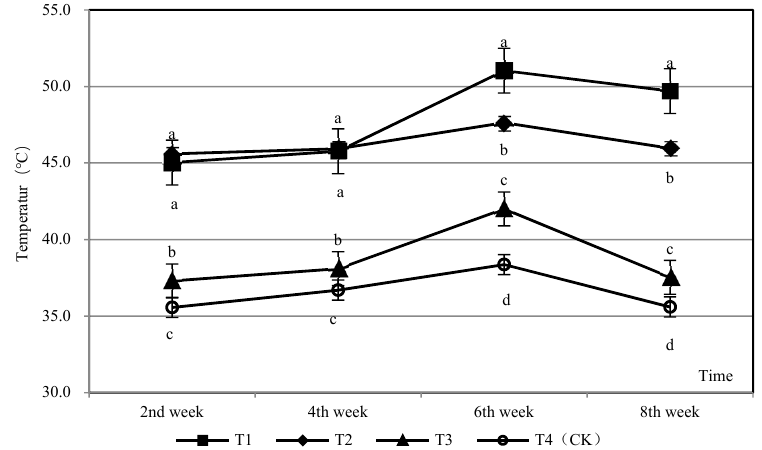
Figure 2. Change of temperature in different treatments. T1: adjust C/N, C/P + 0.2% priming; T2: adjust C/N, C/P + 0.2% common compost; T3: adjust C/N, C/P; T4 (CK): raw material grinding of tending material. Different letters indicate a significant difference at the 0.05 level.